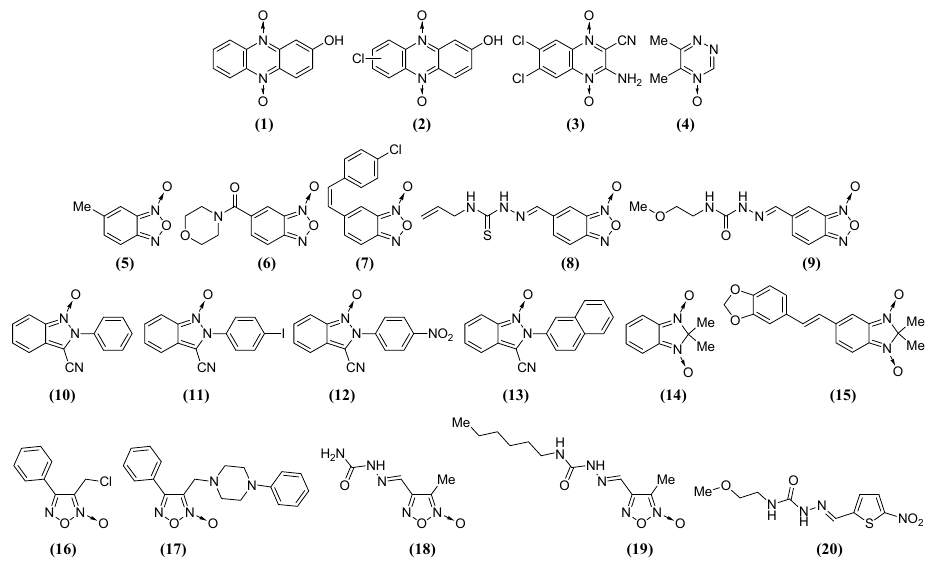
Figure 2. The N -oxides and nitrothiophene from our chemo-library studied herein as rumen fermentation modifiers.